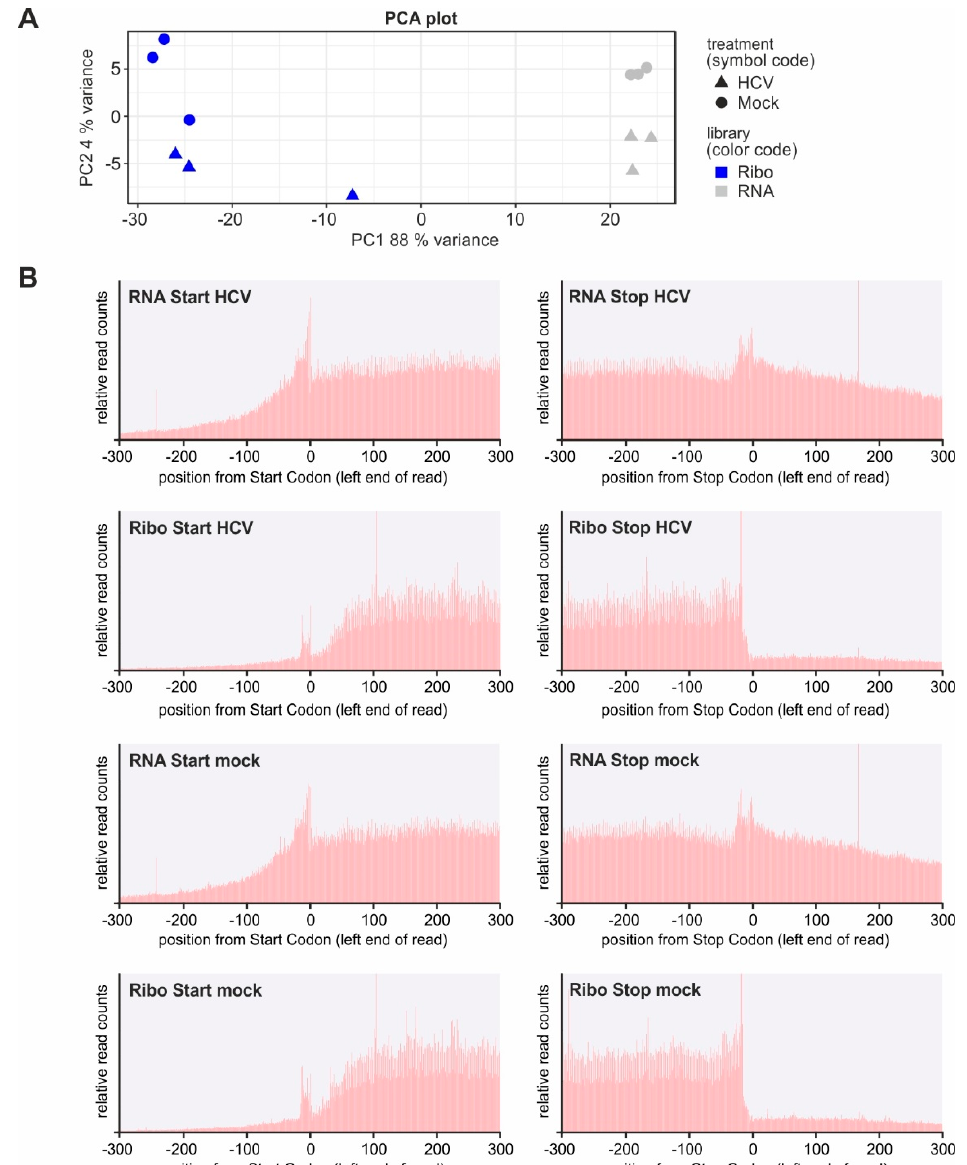
Figure 2. Quality controls of transcriptome and ribosome profiling analyses. ( A ) Principal component analysis (PCA) of gene expression in transcriptome and ribosome profiling replicates. ( B ) Metagene analyses of transcriptome reads (“RNA”) and ribosome profiling reads (“Ribo”) in HCV ‐ replicating cells and non ‐ transfected cells (“Mock”) around the Start and Stop codons of cellular mRNAs.